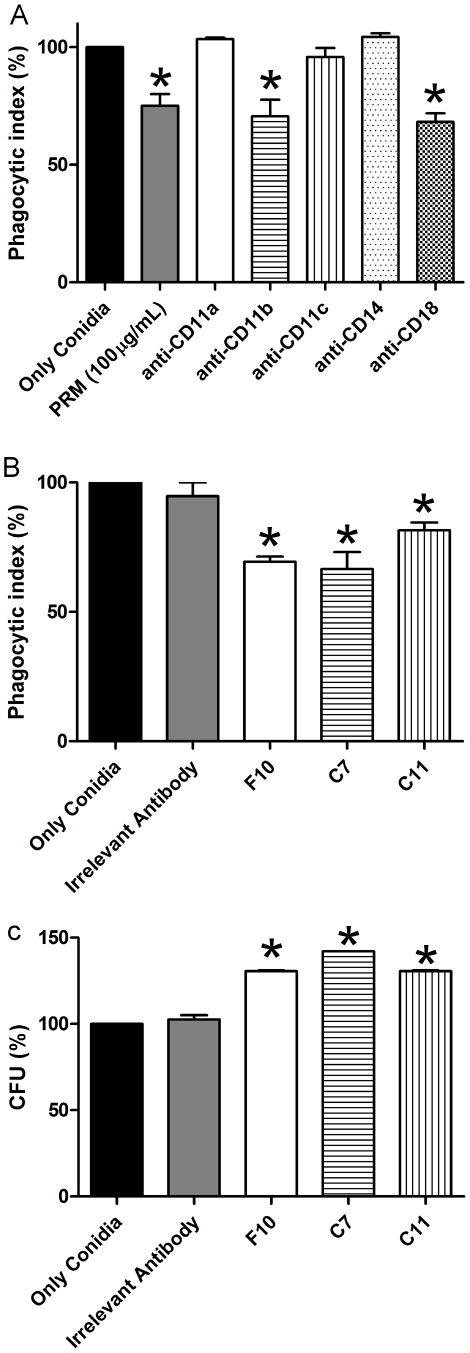
MAbs modify the intracellular fate of S. apiospermum.Effect of purified PRM and blockage of the CD11 and CD18 receptors decreased phagocytosis of S. apiospermum conidia (A) and mAbs to PRM (B) on S. apiospermum phagocytosis by J774.16 cells. Effect of mAbs to PRM on S. apiospermum killing by J774.16 cells (C). In all the panels, the values are the averages of three independent experiments, and the error bars indicate standard deviations. Each experiment was done in triplicate. * P<0.05 for comparison between samples and controls.